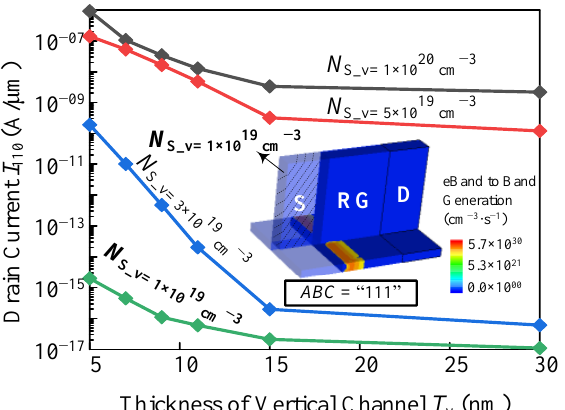
Figure 9. The T v varied with I 110 at N S_v = 1 × 10 20 cm − 3 , 5 × 10 19 cm − 3 , 3 × 10 19 cm − 3 , and 1 × 10 19 cm − 3 in the OrAnd logic device.